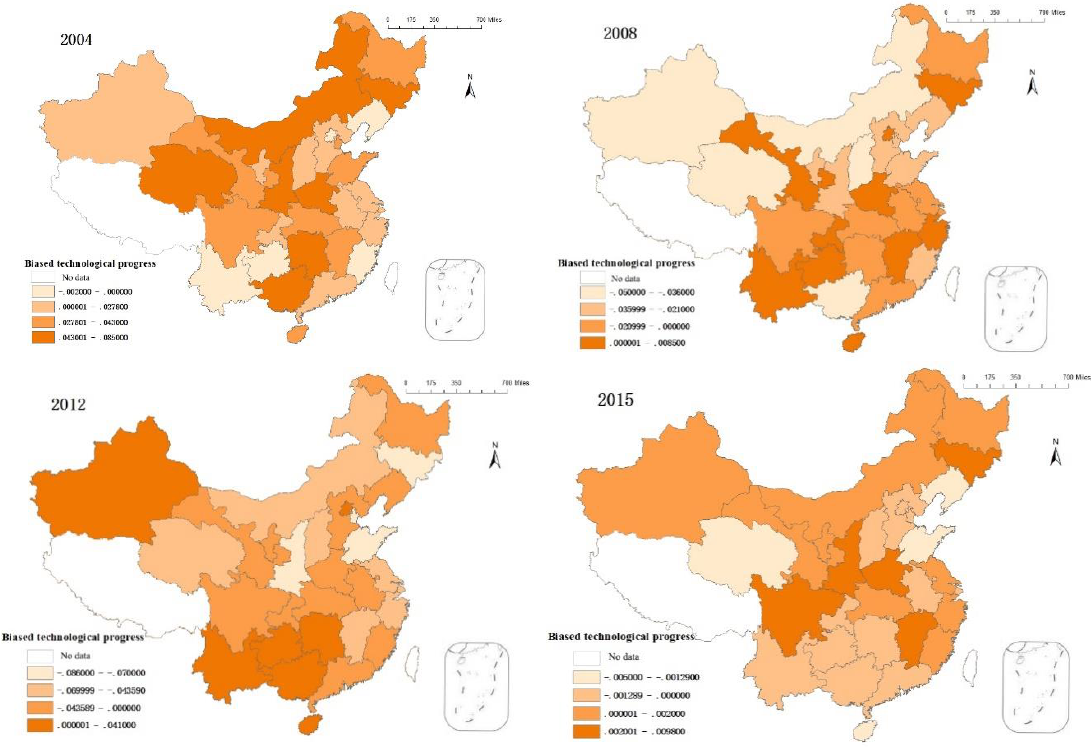
Figure 4. The temporal and spatial evolution of biased technological progress. Table 3. Environmental constraints and technological progress trends in Chinese provinces with exponential